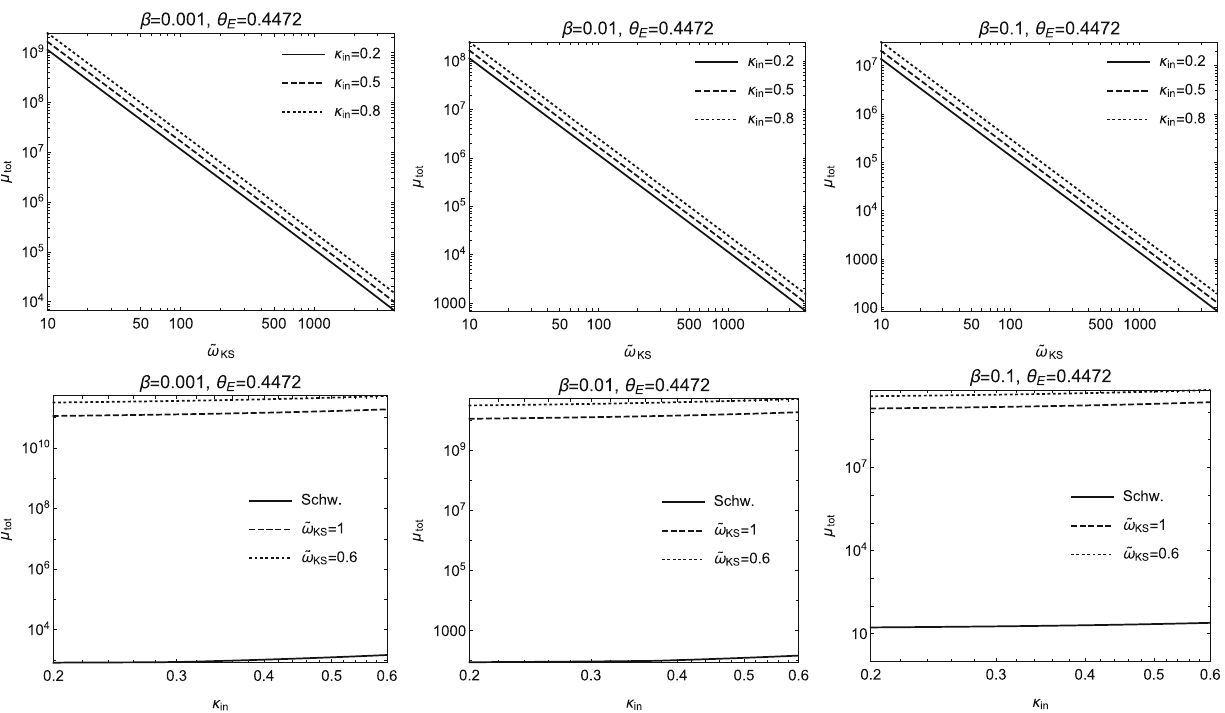
Fig. 10 Inhomogeneous: In the first row, the variation of total mag- nification ( μ tot ) for inhomogeneous distribution (1 / r ) of plasma with nification ( μ tot ) for inhomogeneous distribution (1 / r ) of plasma with plasma parameter for different combinations of angle of source from observer-lens axis ( β ) and dimensionless “Hoˇrava” parameter ( ˜ ω dimensionless “Hoˇrava” parameter ( ˜ ω ) for different combinations of KS angle of source from observer-lens axis ( β ) and plasma parameter keep- keeping θ E = 0 . 4472 ing θ E = 0 . 4472 constant. In the second row, the variation of total mag-